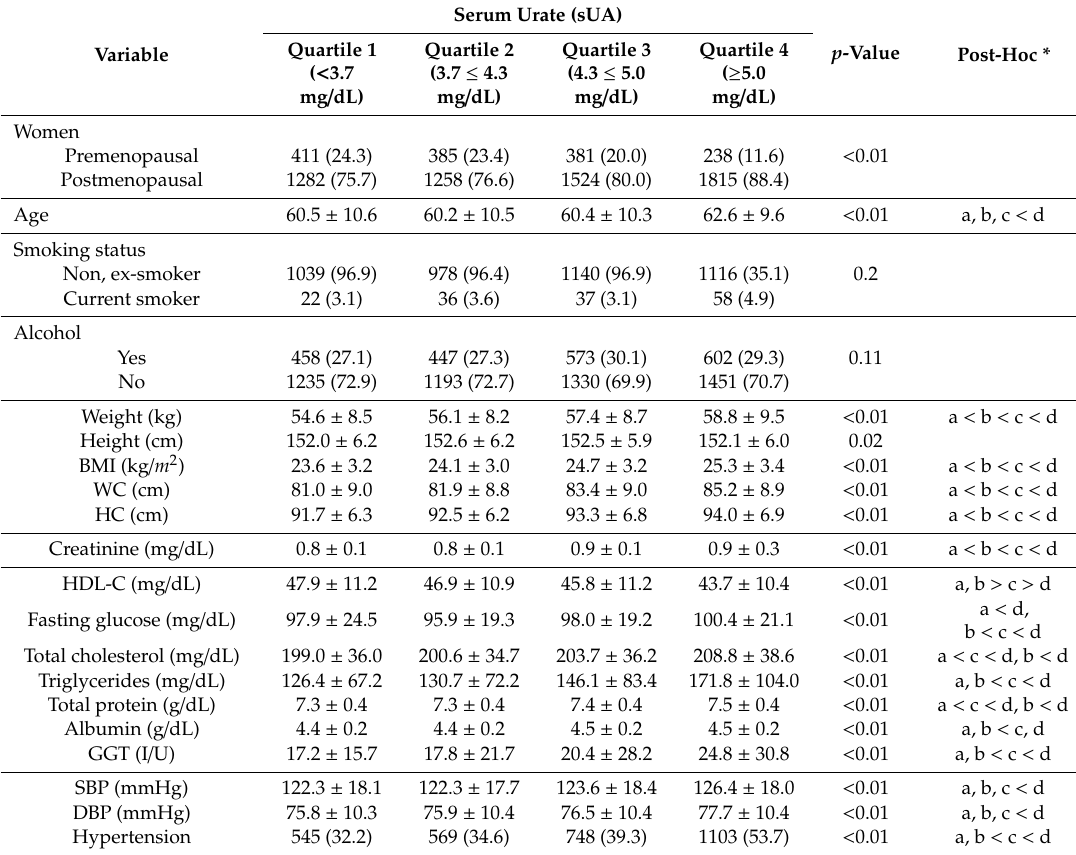
Table 1. Sociodemographic characteristics of the study